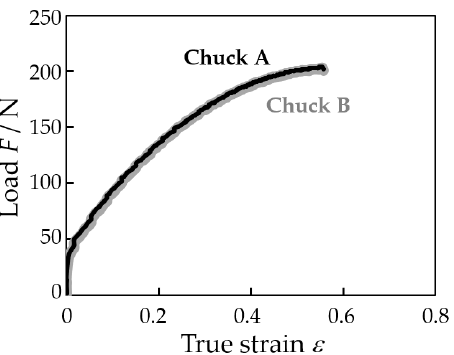
Figure 10. Measurement results of the load obtained by the tensile test of the copper tube using the draw-bench machine without the die. Chucks A and B indicate the chuck of the draw-bench machine on the die’s entrance and exit sides, respectively.